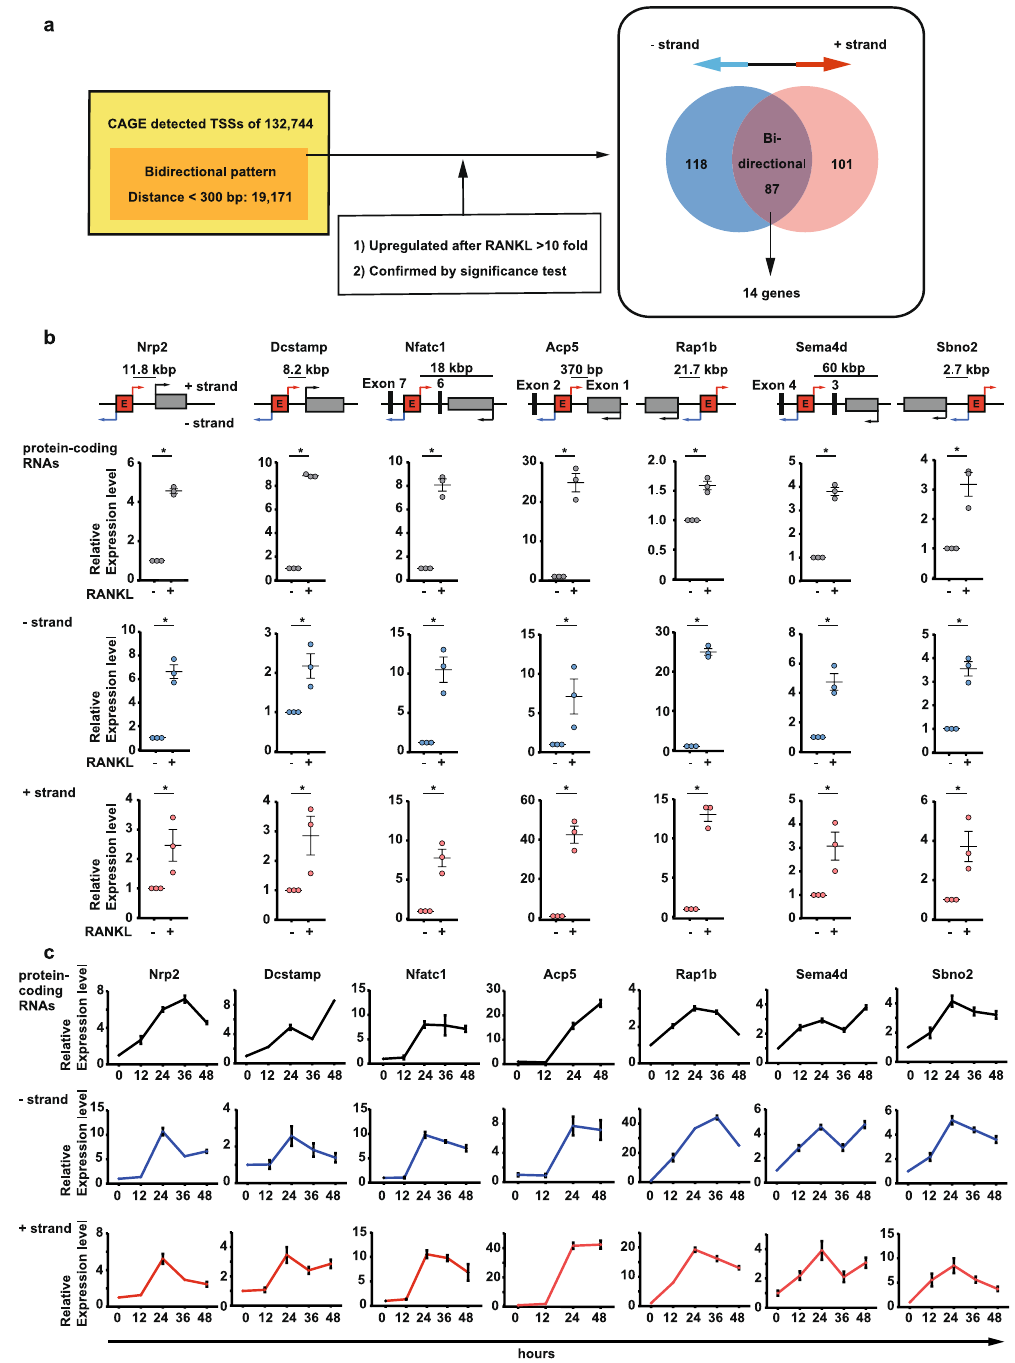
Figure 2. Identification of enhancer RNA (eRNA) candidates induced by RANKL stimulation. ( a ) A summary of the pipeline for bidirectional transcription and the selection of highly altered ( > 10-fold) RNA levels, confirmed using the significance test. A Venn diagram of bidirectional transcription for the selection of putative eRNA regions associated with osteoclasts. ( b ) Schematic diagram of the genomic loci of Nrp2, Dcstamp, Nfatc1, Acp5, Rap1b, Sema4d, and Sbno2. Quantitative RT-PCR (qRT-PCR) analysis of the relative expression levels of protein-coding RNAs, as well as the − and + strand RNAs following RANKL stimulation for 2 days in RAW 264.7 cells. Data are the mean ± standard error of the mean (SEM); n = 3 biological replicates with 3–4 technical replicates each. * P < 0.05 (Student’s t -test) ( c ) Time-course analyses of RANKL-induced alterations in protein- coding RNAs, as well as the − and + strand RNAs of Nrp2, Dcstamp, Nfatc1, Acp5, Rap1b, Sema4d, and Sbno2. Analyses were performed on total RNAs. Data are the mean ± SEM; n = 3 biological replicates with 3–4 technical replicates